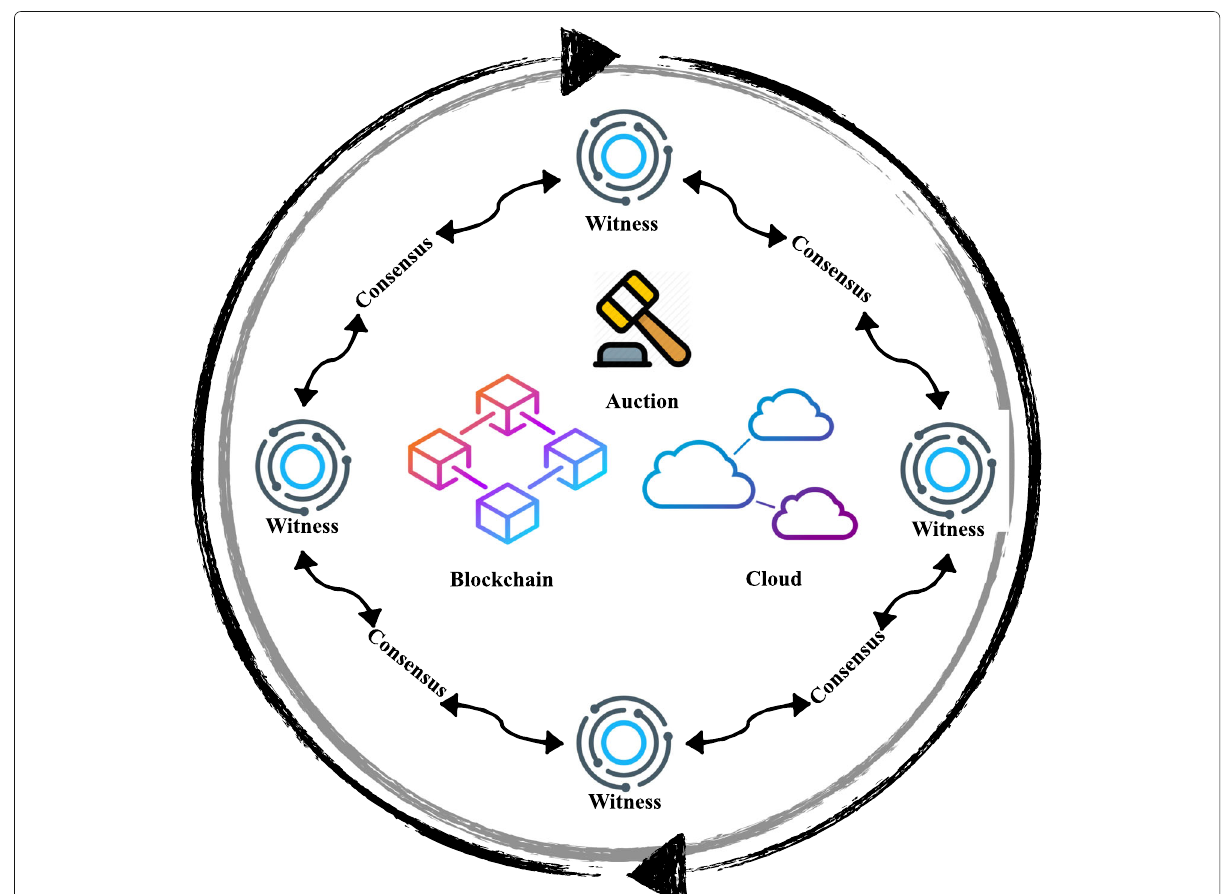
Fig. 1 An illustration of an AWESOME decentralized cloud marketplace